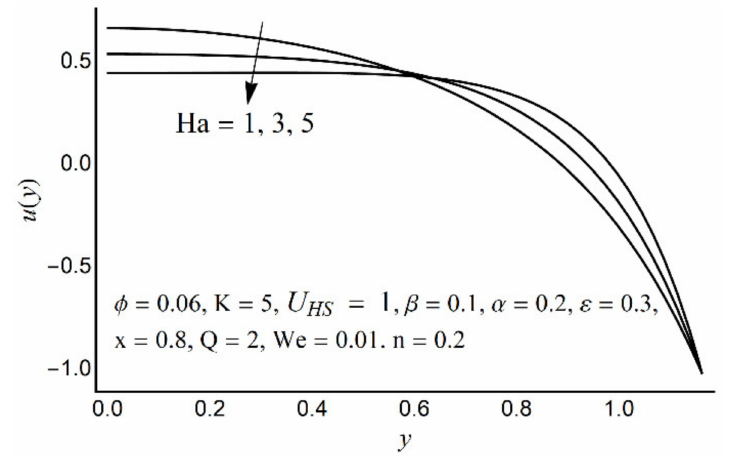
Figure 2. Axial velocity u ( y ) for various Ha.